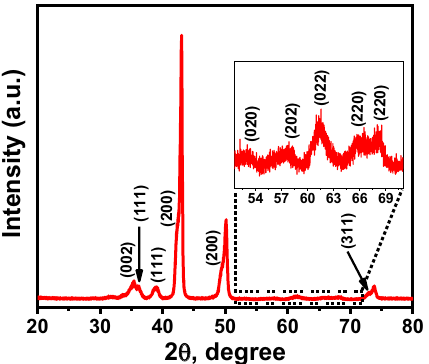
Figure 3. XRD pattern of the fabricated photocathode annealed at 350 °C in the air for 1 h.